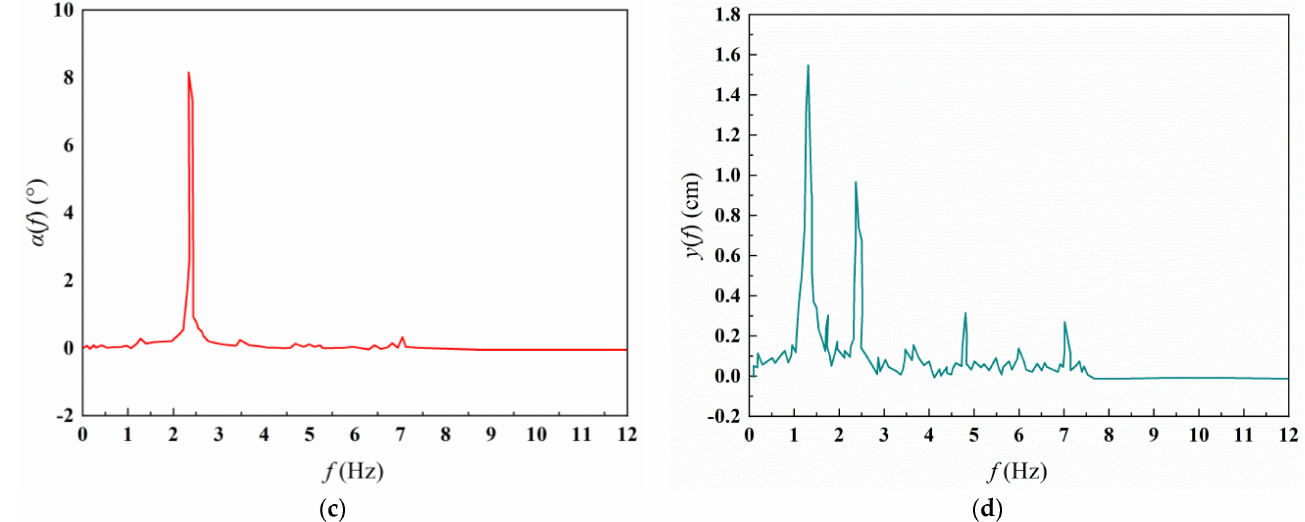
Figure 8. Time histories and frequency spectra of the torsional and the vertical vibration of the big wind fairing section, +5 ◦ angle of attack, U = 44.7 m/s: ( a ) Torsional displacement time history; ( b ) Vertical displacement time history; ( c ) Torsional displacement spectrum; ( d ) Vertical displacement spectrum.